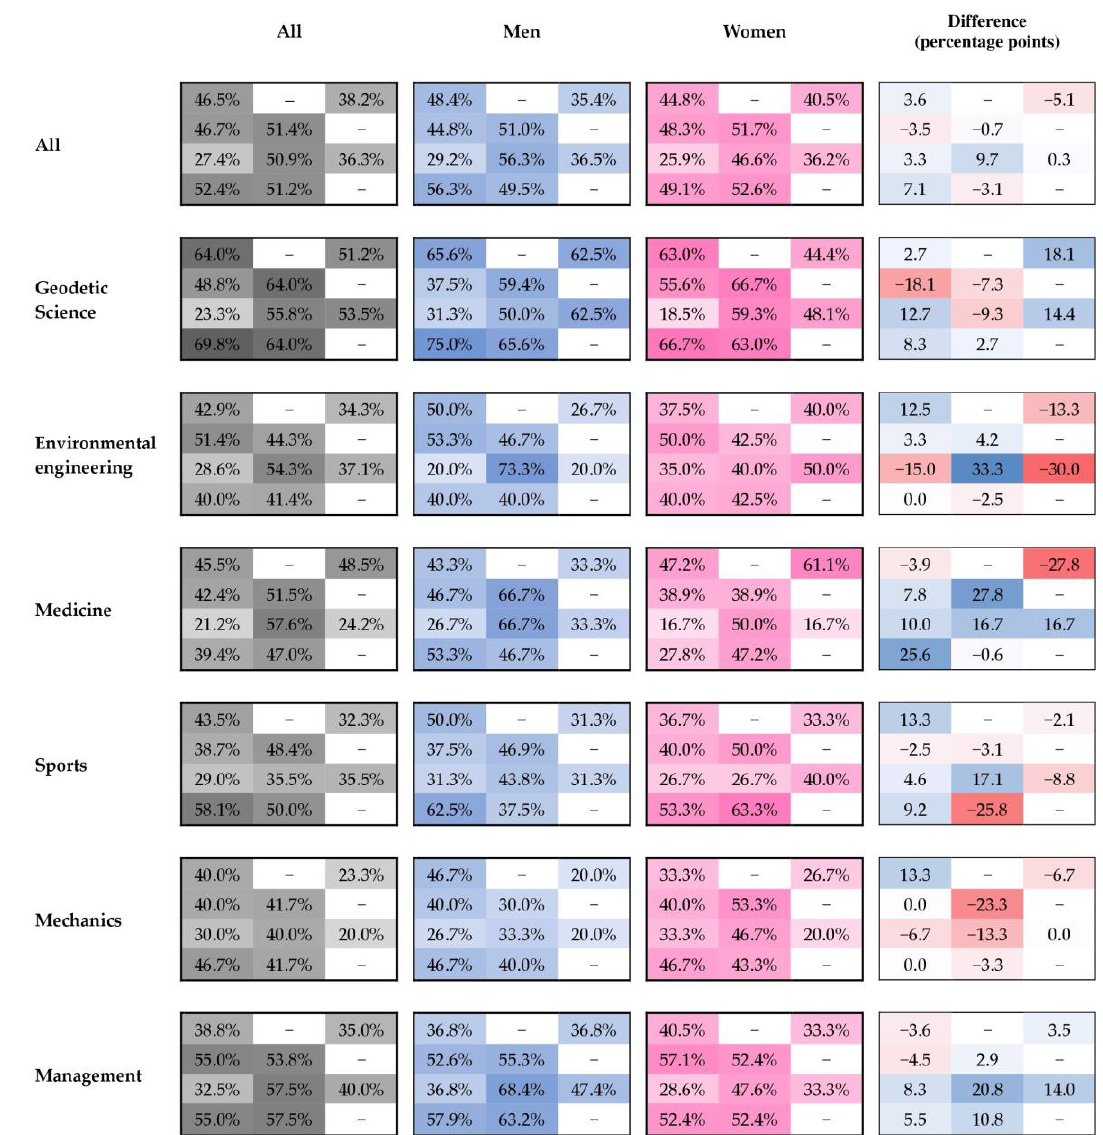
Figure 9. The percentage of correct answers depending on the visualization parameters used to show the specific right assigned to the property (based on rules provided in Figure 8).